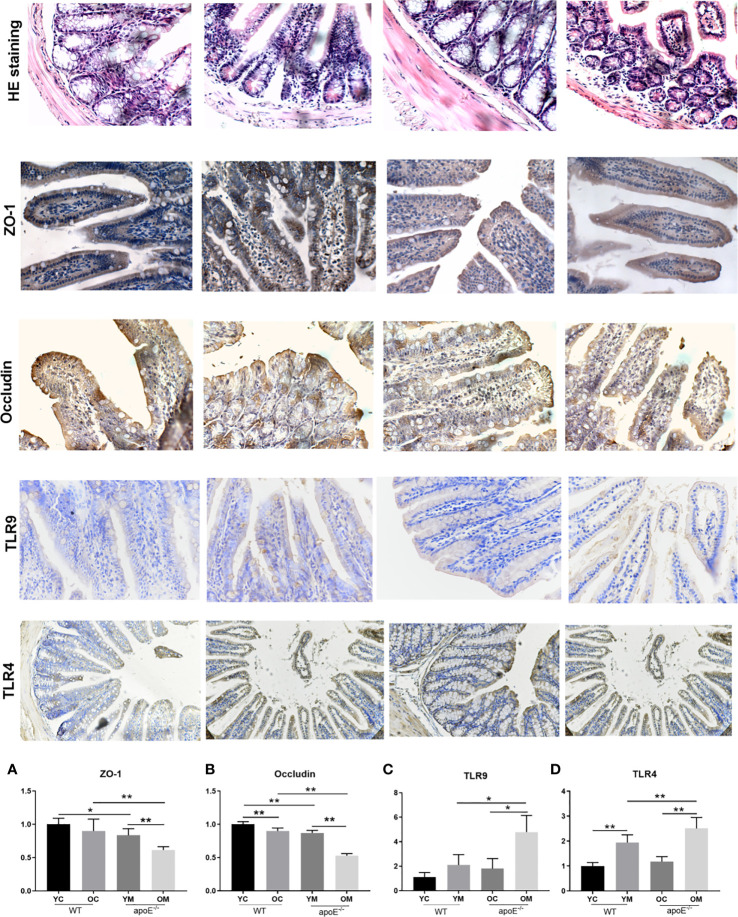
Quantification of ileal mucosal barrier dysfunction, n=4 in each group. HE staining and immunohistochemical staining of ZO-1, Occludin, TLR-9 and TLR-4 in ileal mucosal; The rest of the columns represent the expression levels of ZO-1, Occludin, TLR-9 and TLR-4 in ileal mucosal. Data were shown as mean ± SD. *P<0.05; **P < 0.01. p values are calculated from T-test.